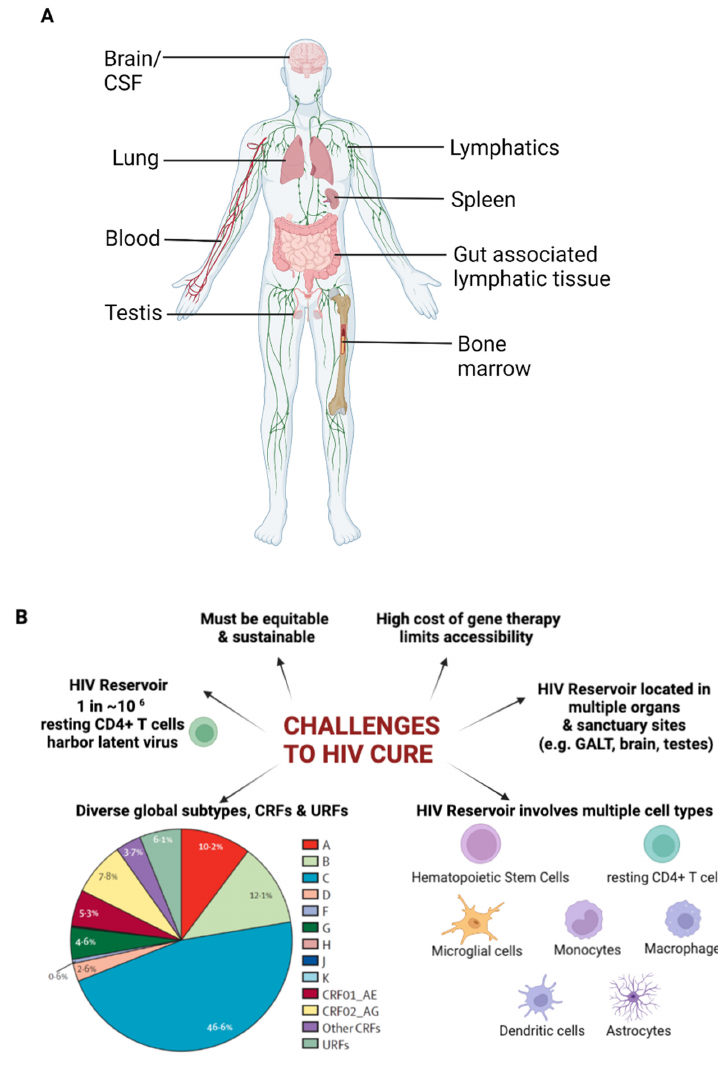
Figure 2. Challenges associated with HIV infection. ( A ) Illustration showing the distribution of organs and tissues known to harbour latent HIV ( B ) Challenges in attaining HIV cure. Created with BioRender.com.